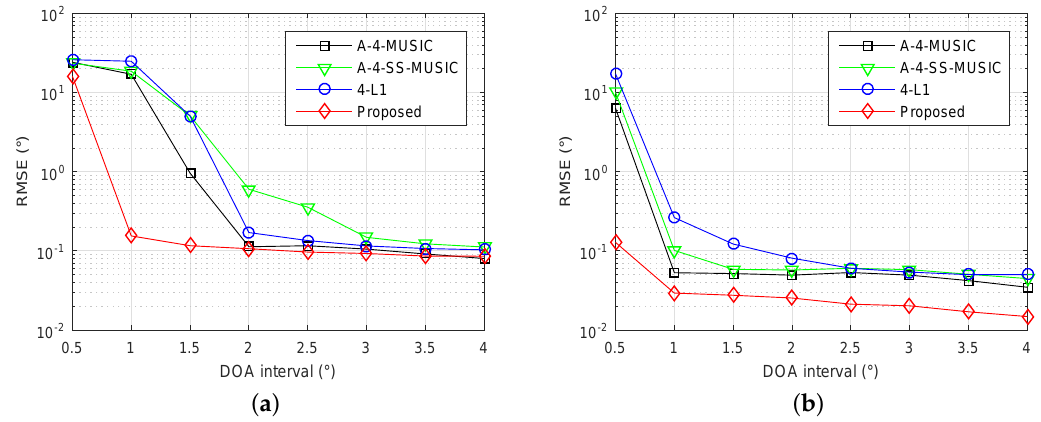
Figure 3. RMSE performance of four methods with different DOA intervals, S = { 1,2,4,11,25 } × d , K = 2, r = 0.1 ◦ , ( a ) L = 300 and SNR = 3 dB, ( b ) L = 1000 and SNR = 10 dB.